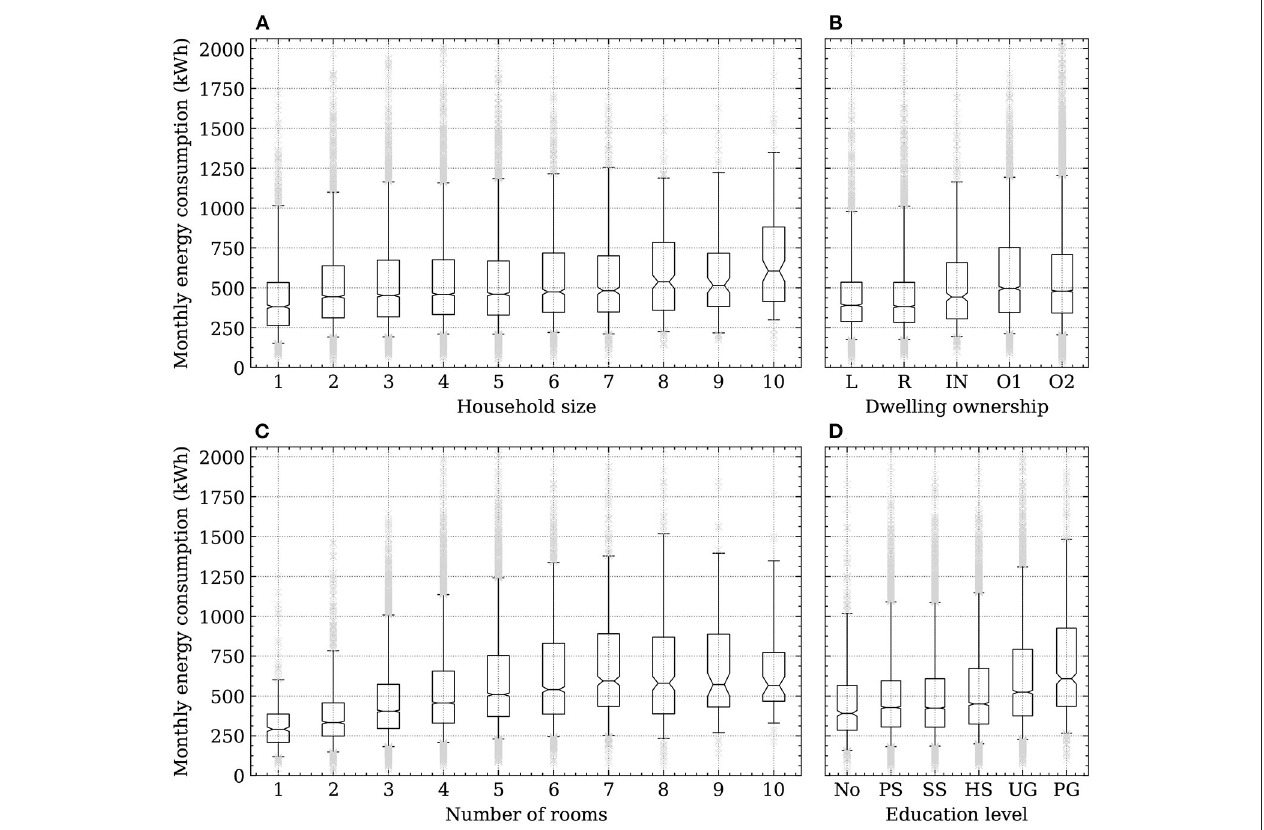
FIGURE 5 | Socio-demographic variables and household energy consumption. (A) Number of persons living in the household. (B) Status of household ownership: R, rented; L. loaned; O1, own and still paying; O2, owned and paid; IN, intested. (C) Number of rooms in the dwelling. (D) Completed education level of the household head: no education, PS, primary school; SS, secondary school; HS, high school; UG, undergraduate studies; PG, postgraduate